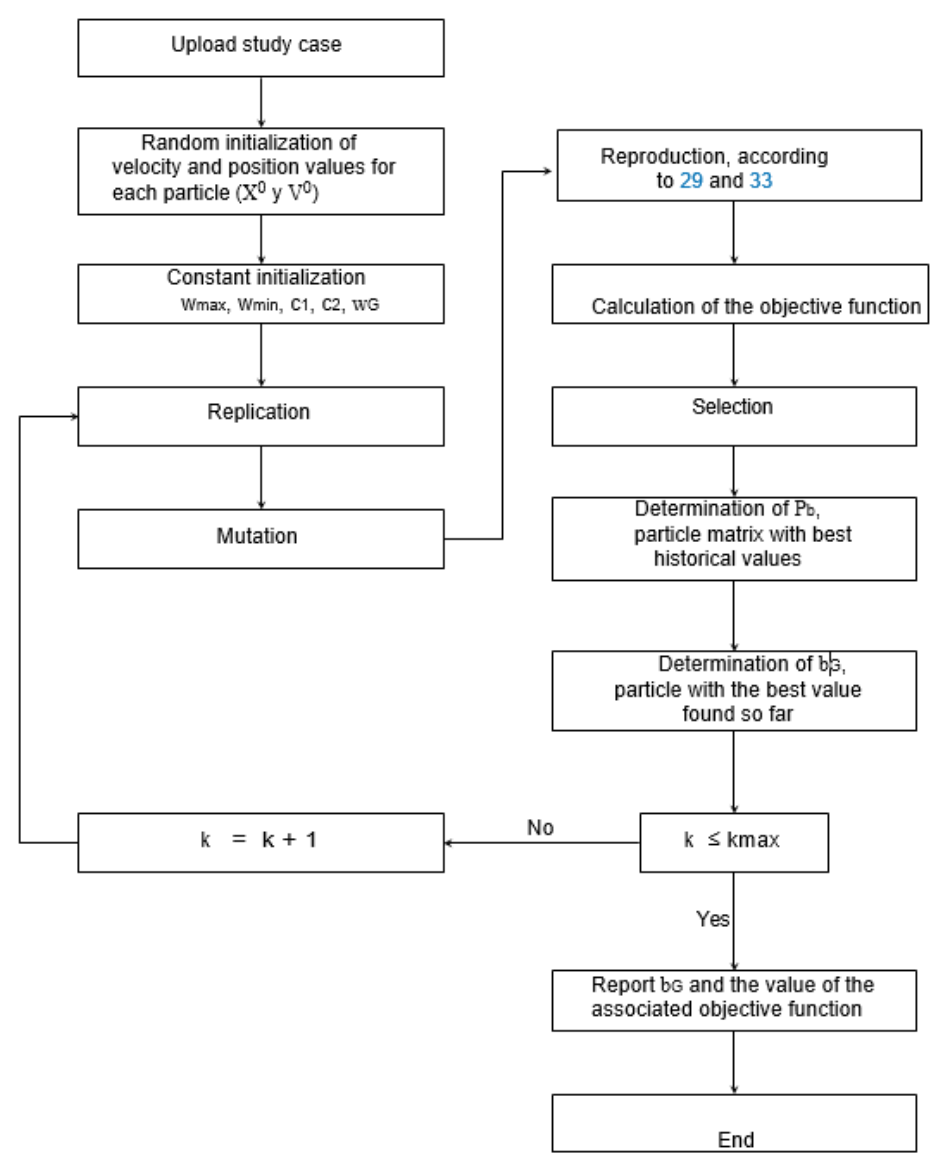
Figure 2. Flow diagram of the implemented DEEPSO